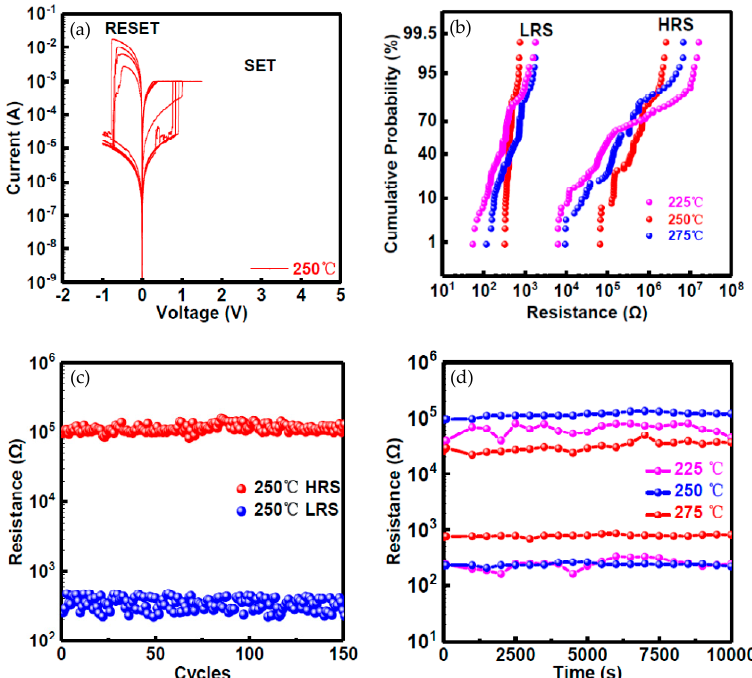
Figure 7. RS performance, including ( a ) bipolar I-V characteristic, ( b ) resistance distribution, ( c ) endurance and ( d ) retention performance, of Ni/solution-processed AlO x /Pt RRAM devices annealed ( c ) endurance and ( d ) retention performance, of Ni / solution-processed AlO x / Pt RRAM devices at different temperatures, reproduced from [9], with permission from MDPI (Basel, Switzerland), 2019.